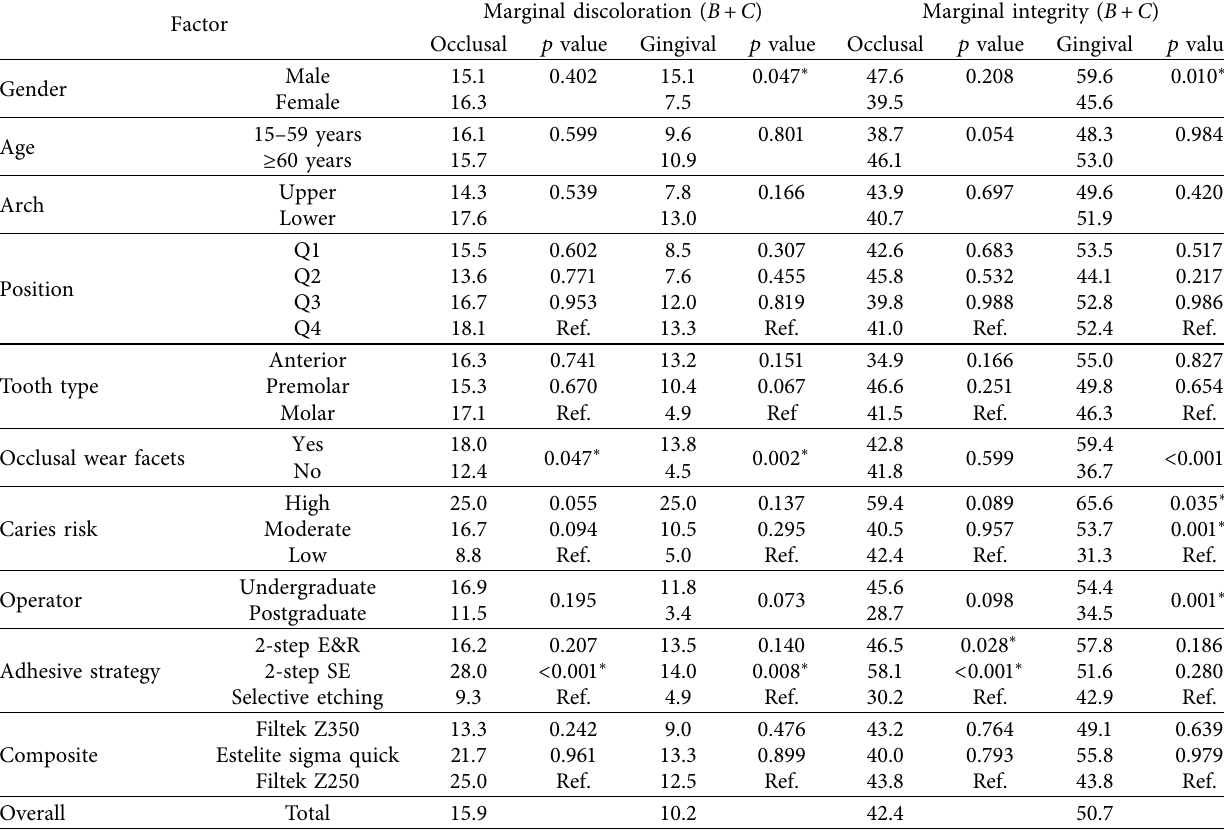
Table 3: Distribution of the marginal discoloration and marginal integrity failure related to various factors presented as percentages.